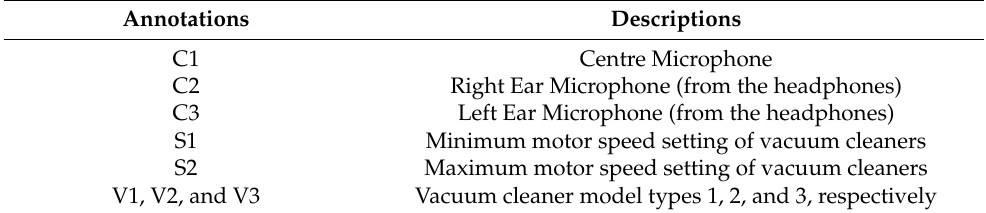
Table 2. Annotations used in the